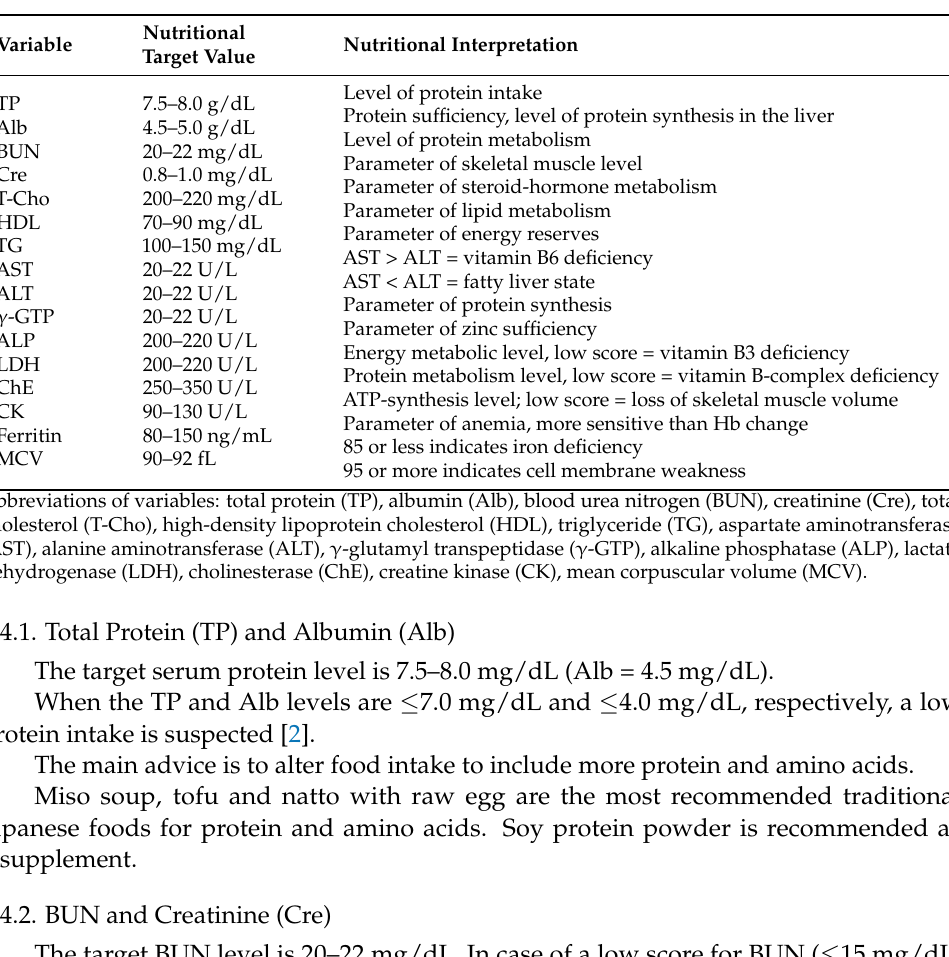
Table 1. Nutritional target values in blood test